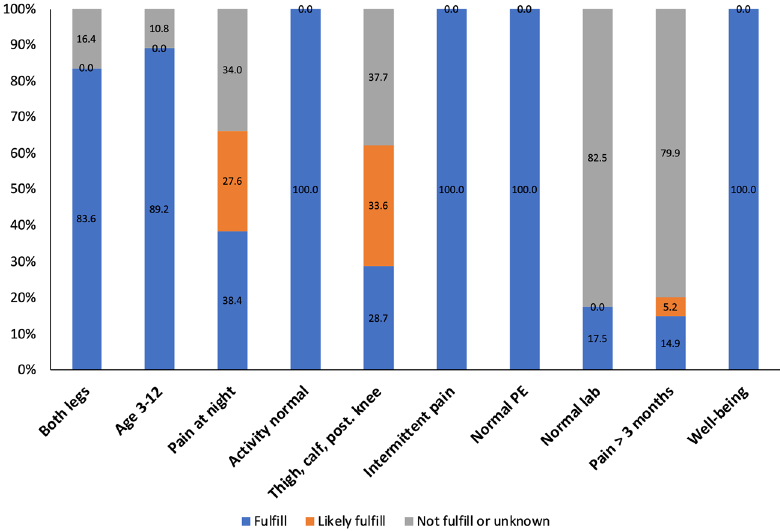
Figure 2. Percentage of fulfillment, likely fulfillment, and no fulfillment of ten Walters’s criteria of growing